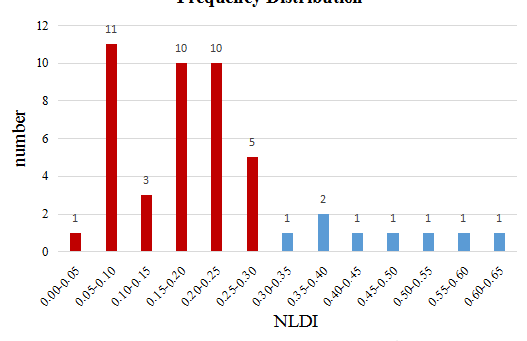
Figure 12. The NLDI values for the five Central Asian countries